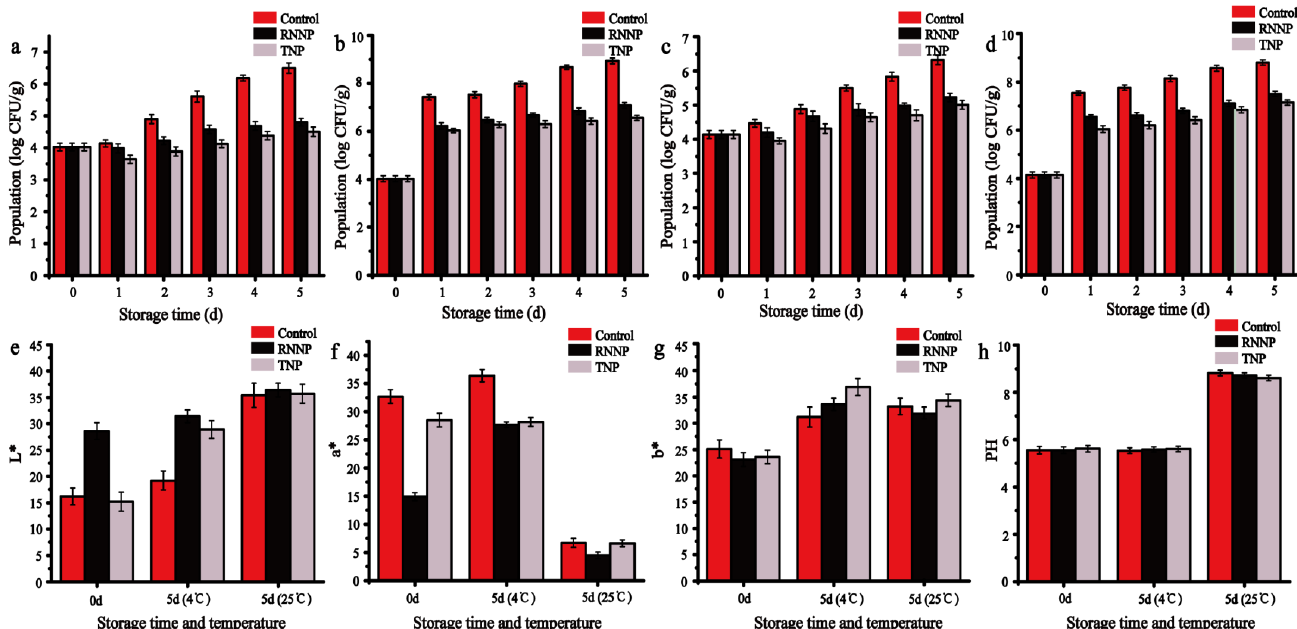
Figure 7. The application of nanoparticles in beef including antibacterial activity of RNNP and TNP against S. aureus at 4 °C ( a ) and 25 °C ( b ); The antibacterial activity of RNNP and TNP against E. coli O157:H7 at 4 °C ( c ) and 25 °C ( d ); color analysis of beef treated with RNNP and TNP at 4 °C and 25 °C ( e – g ); PH of beef treated with RNNP and TNP at 4 °C and 25 °C ( h ).